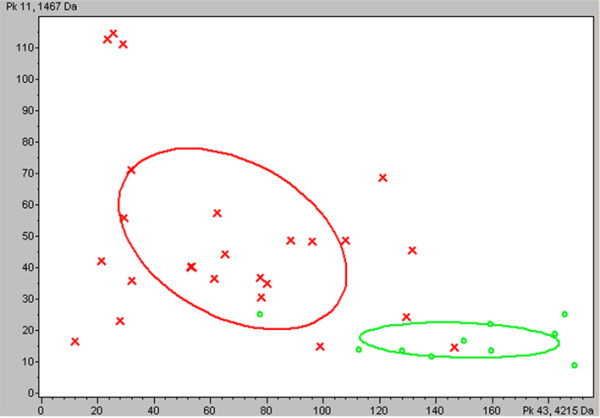
Two dimensional peak distribution view of the two peaks (m/z 1467 and 4215). The peak area and the m/z values are indicated on the x- and y-axes. The ellipses represent the standard deviation of the class average of the peak areas/intensities. Red represents colorectal cancer patients and green represents healthy volunteers.